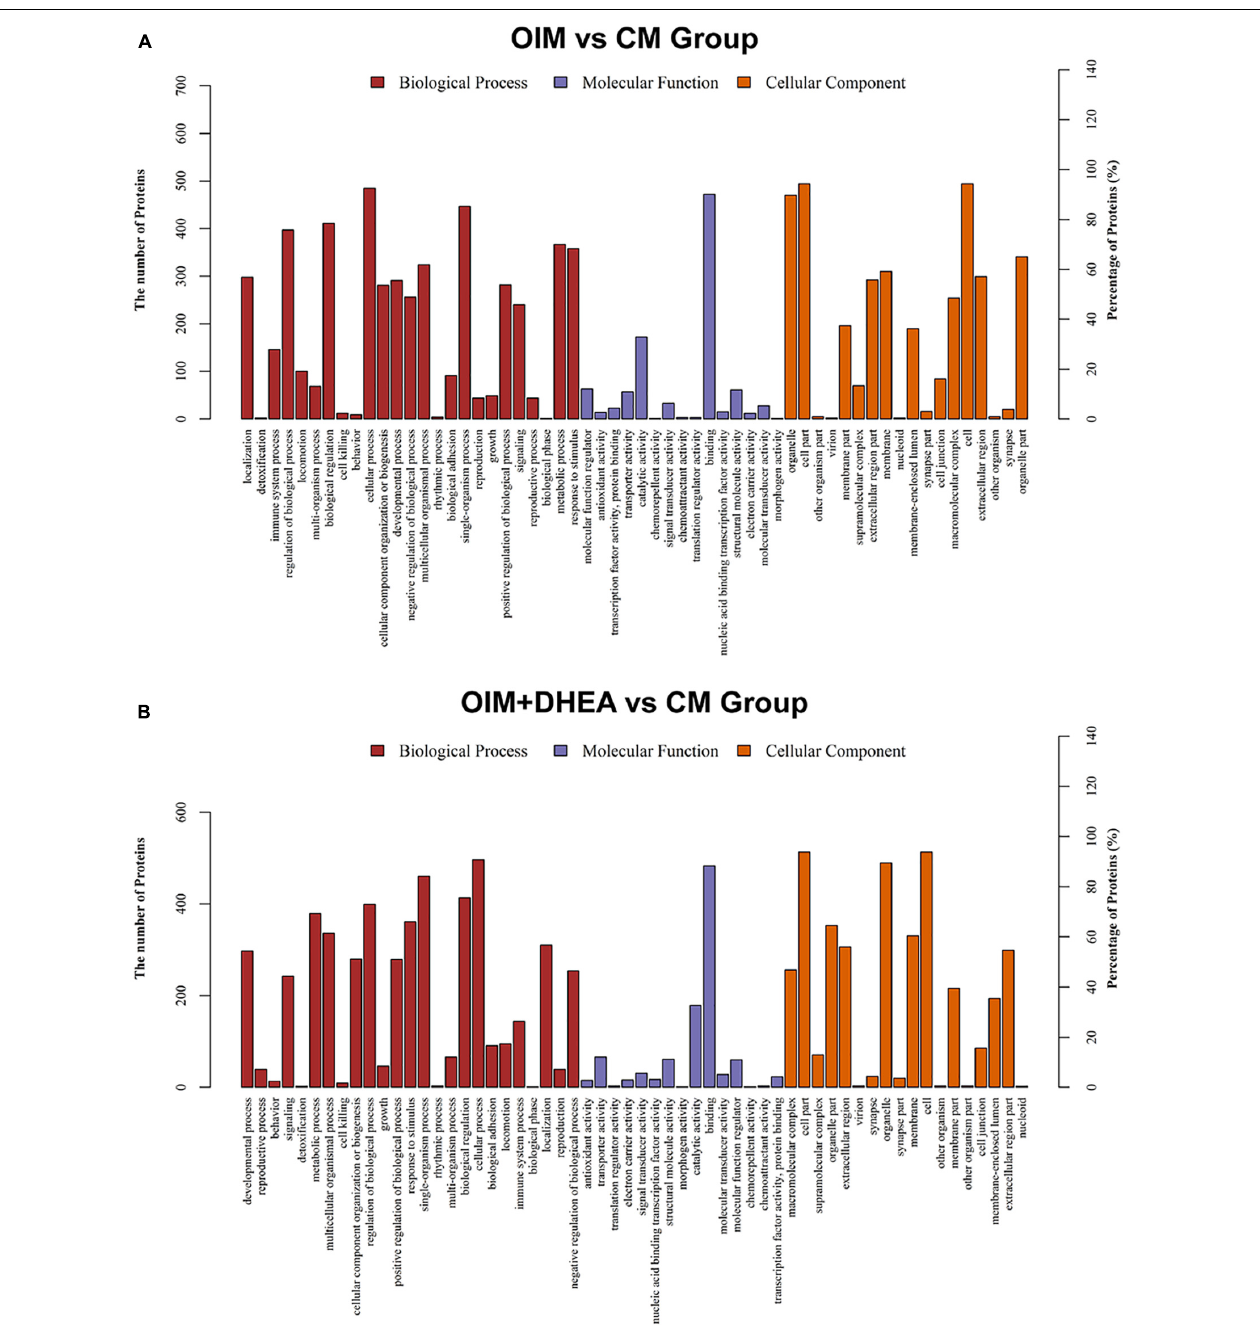
FIGURE 4 | Gene ontology (GO) classification of differentially expressed proteins (DEGs). GO analysis of DEGs in OIM+DHEA vs. CM group (A) and OIM+DHEA vs. CM group (B) . Cut-off value: p -value < 0.05, and count > 2.